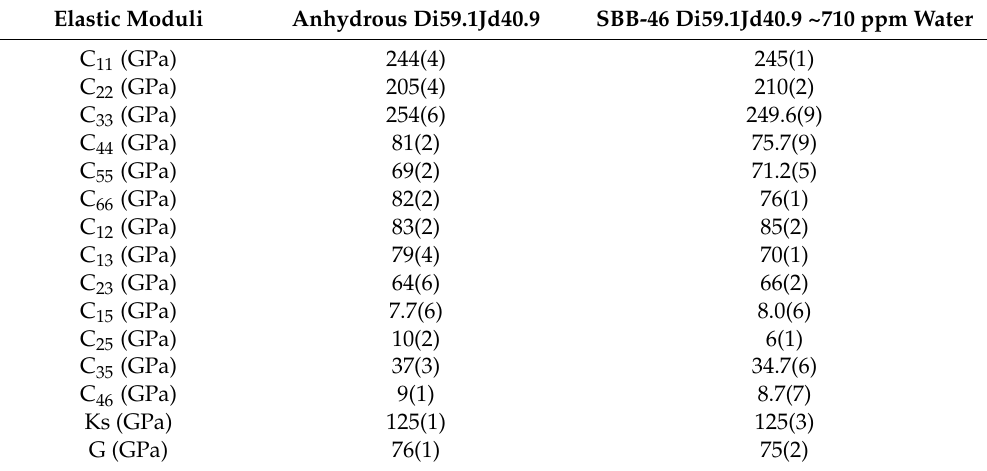
Figure 3. Single-crystal elastic properties of SBB-46 compared with previous studies on anhydrous omphacites within the Di–Jd solid solution as measured by ( a ) Sang et al., 2011 [39], ( b ) Bhagat et al., [40], ( c ) Kandelin and Weidener, 1988 [41], ( d ) Collins and Brown, 1998 [42], ( e ) Isaak and Ohno, 2003 [43], ( f ) Hao et al., 2019 [44]. The results are compared with the hydrous omphacite measured in ( g ) this study. Dashed lines show the compositional dependence of C ij s , K s , and G . Shaded regions represent the 95% confidence intervals determined in [44]. Table 1. Elastic moduli of the hydrous omphacite sample measured in this study and the anhydrous omphacite with the same chemical composition predicted from Hao et al., 2019 [44]. The uncertainties for the anhydrous omphacite are defined by the 95% confidence intervals shown in Figure 3.